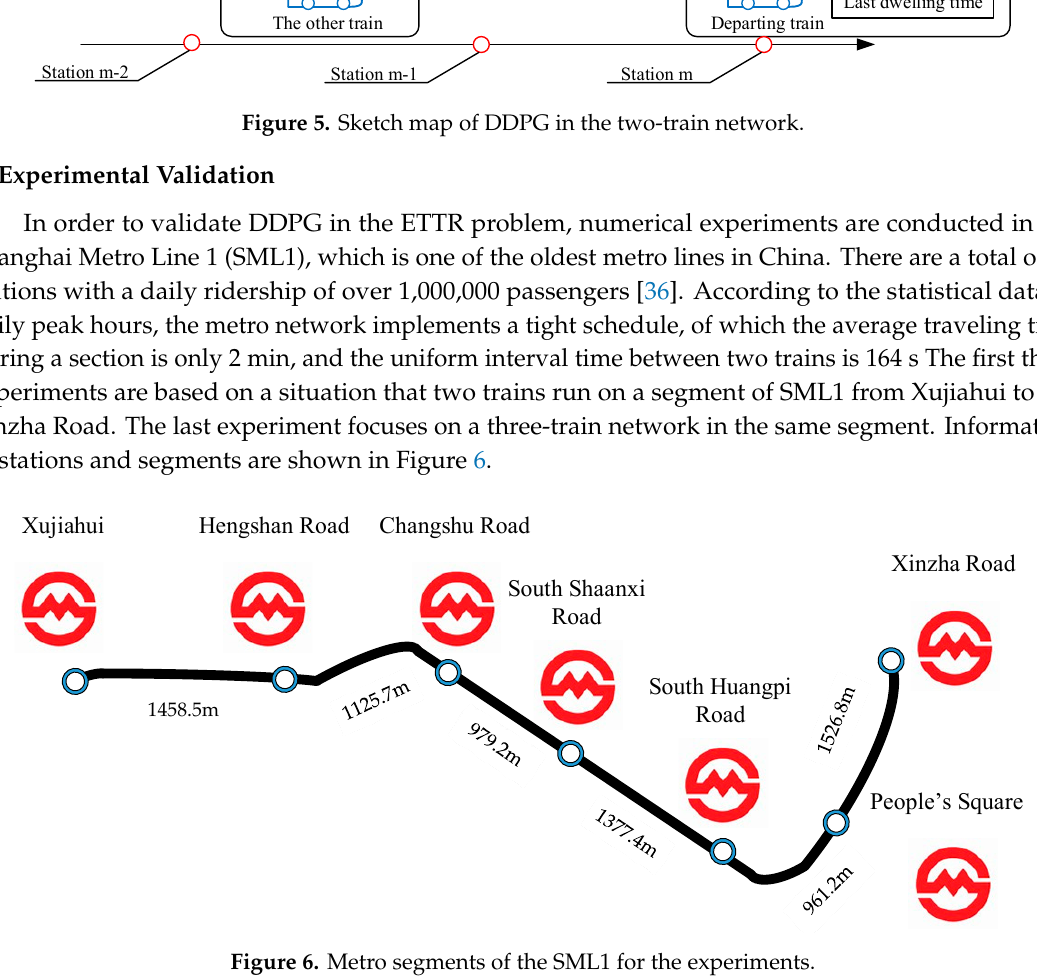
Table 1. Optimal selection by GA in the two-train network.